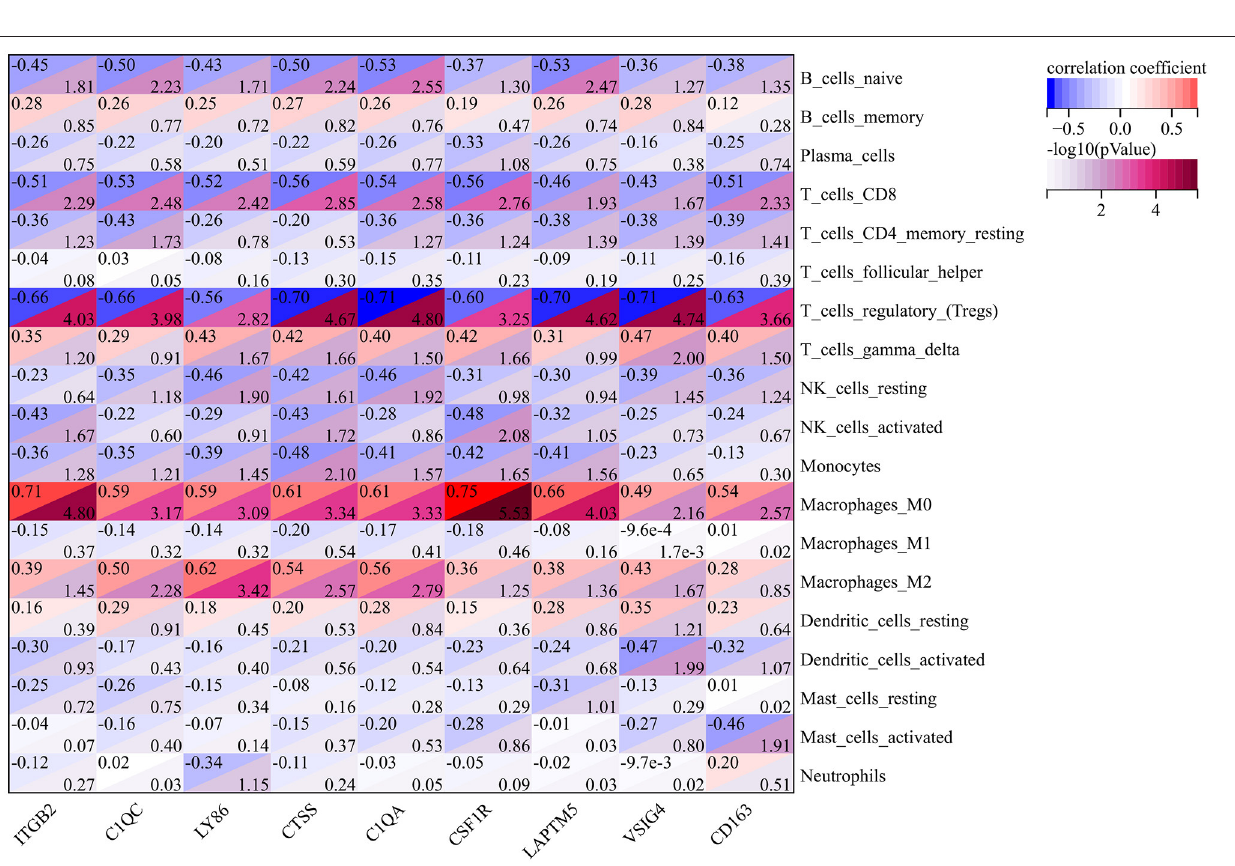
FIGURE 4 | The Pearson Correlation Analysis between the cluster genes and immune cells. The values in the top left corner of the rectangle represent the correlation coefficient, and the values in the lower right corner of the rectangle represent -log10 ( p-